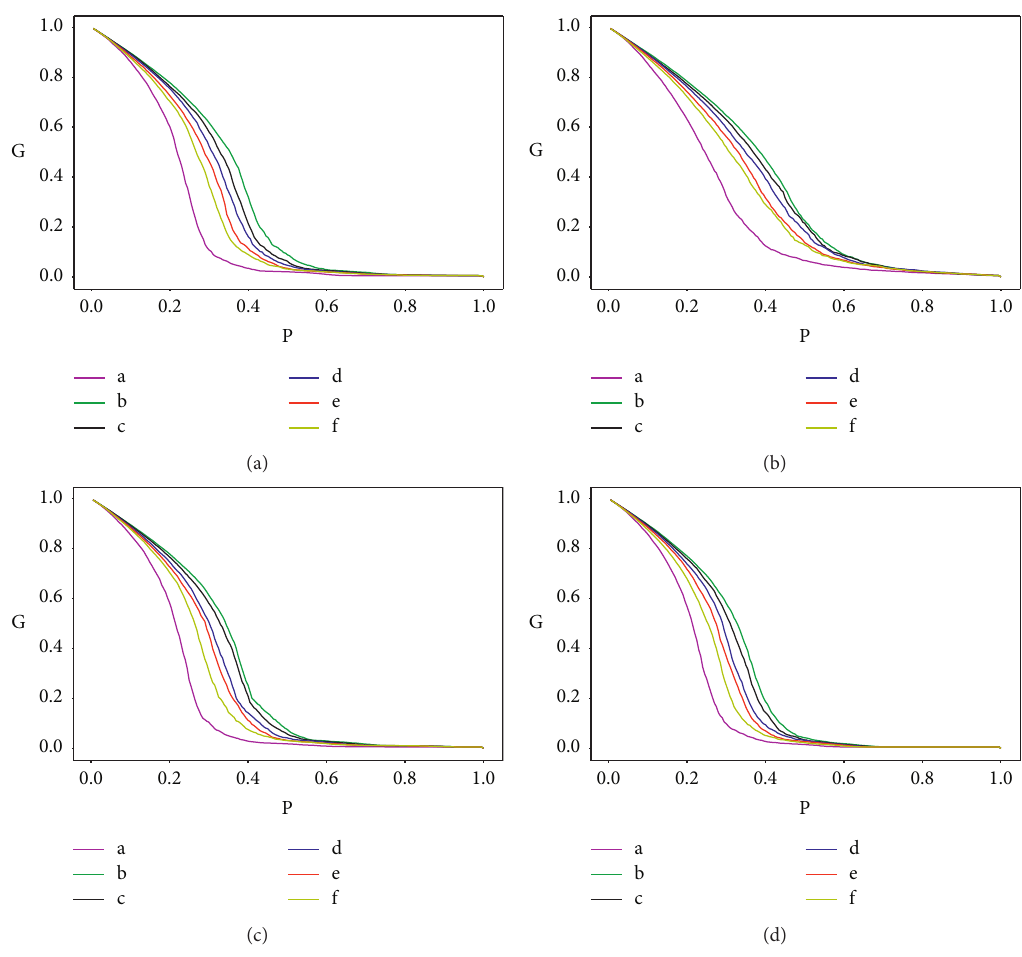
Figure 3: The change of the maximum connectivity coefficient G after model A is attacked by different algorithms, where N � 200, M � 3, curve A represents the BA network, and curve b–f represents the comparison of different parameters of model A (where threshold � 0.1–0.5, changes � 0.003). (a) deg, (b) SL, (c) LLS, and (d)